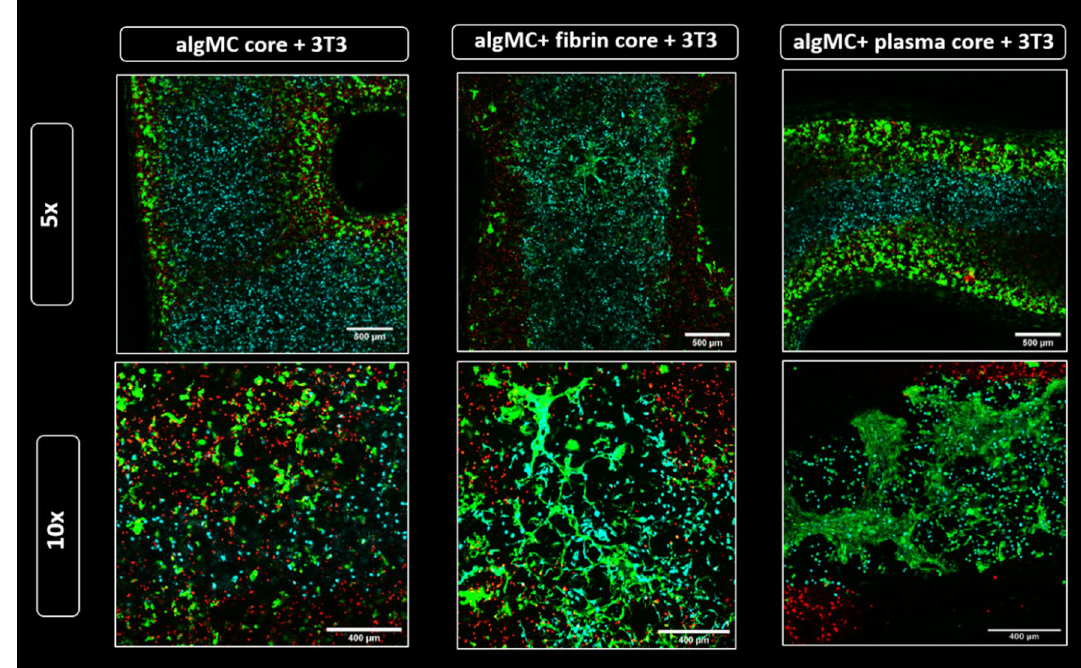
Figure 11. Fibroblasts network formation in the core compartment at day 7 of co-culture. Confocal images of core–shell hydrogel strands with encapsulated DiD-labeled HepG2 (red) in algMC + Matrigel shell and DiI-labeled NIH 3T3 fibroblasts (cyan) embedded in the core of algMC, algMC supplemented with fibrin and algMC supplemented with plasma. Viable cells are stained green with Calcein AM, indicating formation of fibroblast networks within the fibrin- and plasma-functionalized core while a round morphology of the fibroblasts is maintained in unmodified algMC core. Upper tile gives an overview of a section of the core–shell strand; magnification 5x, scale bar 500 µm. Lower tile shows higher magnification (10x) images of NIH 3T3 fibroblasts in the core; Scale bars 400